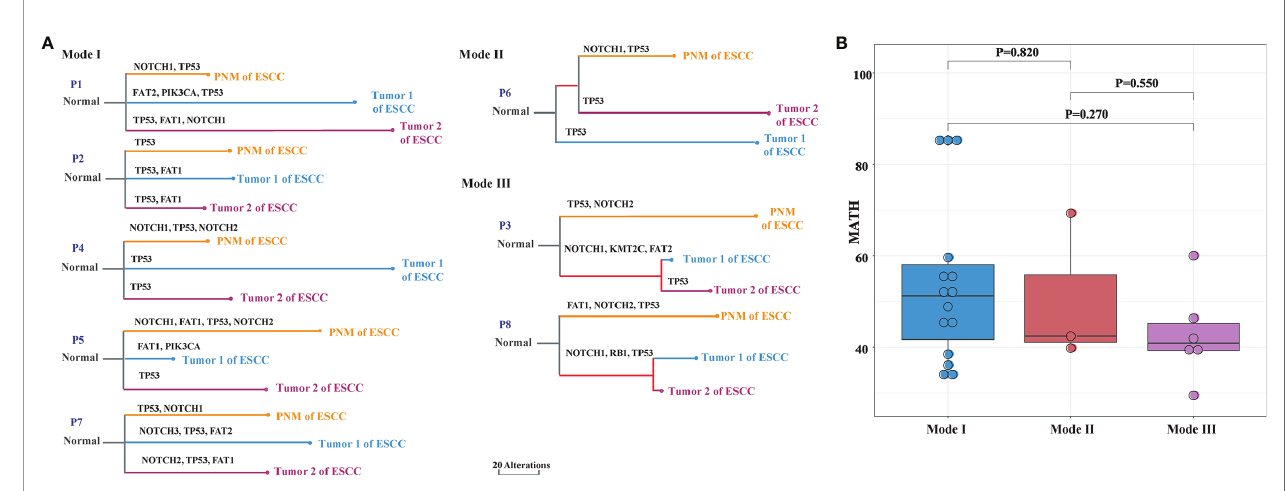
FIGURE 5 | Phylogenetic analysis of ESCC PNM and tumor in multiple primary ESCC. (A) Phylogenetic trees demonstrating the three primary tumor evolutionary modes between primary tumors and corresponding PNM. The colors of lines and nodes denote different tissue samples. The branch length is in the scale of alterations with the scale bar indicating 20 alterations. (B) The MATH scores of each tissue sample that are grouped by evolutionary